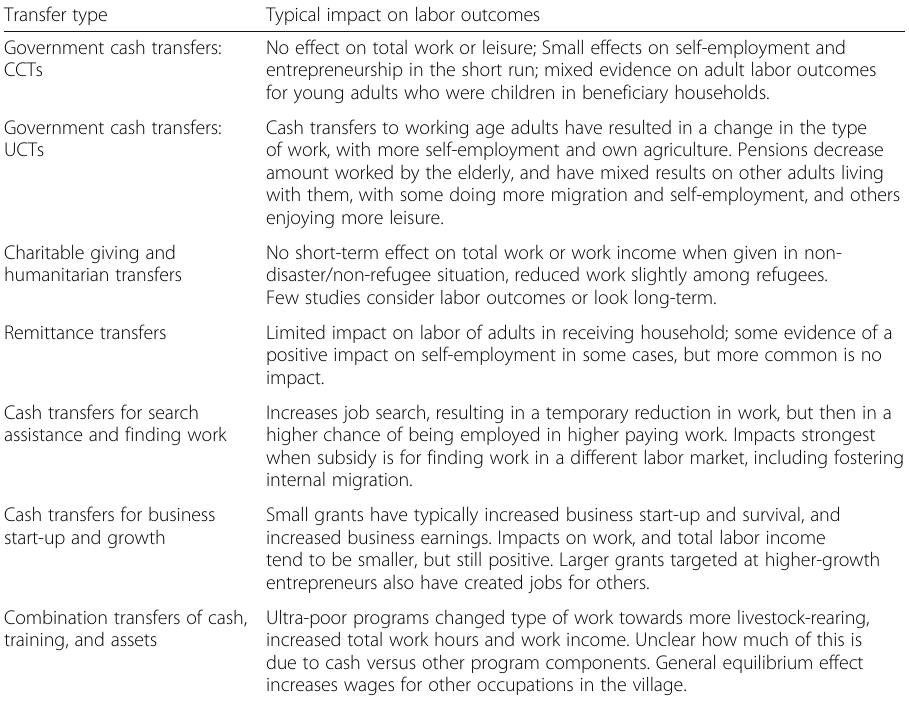
Table 1 Summary of adult labor impacts of different types of cash transfers Transfer type Typical impact on labor